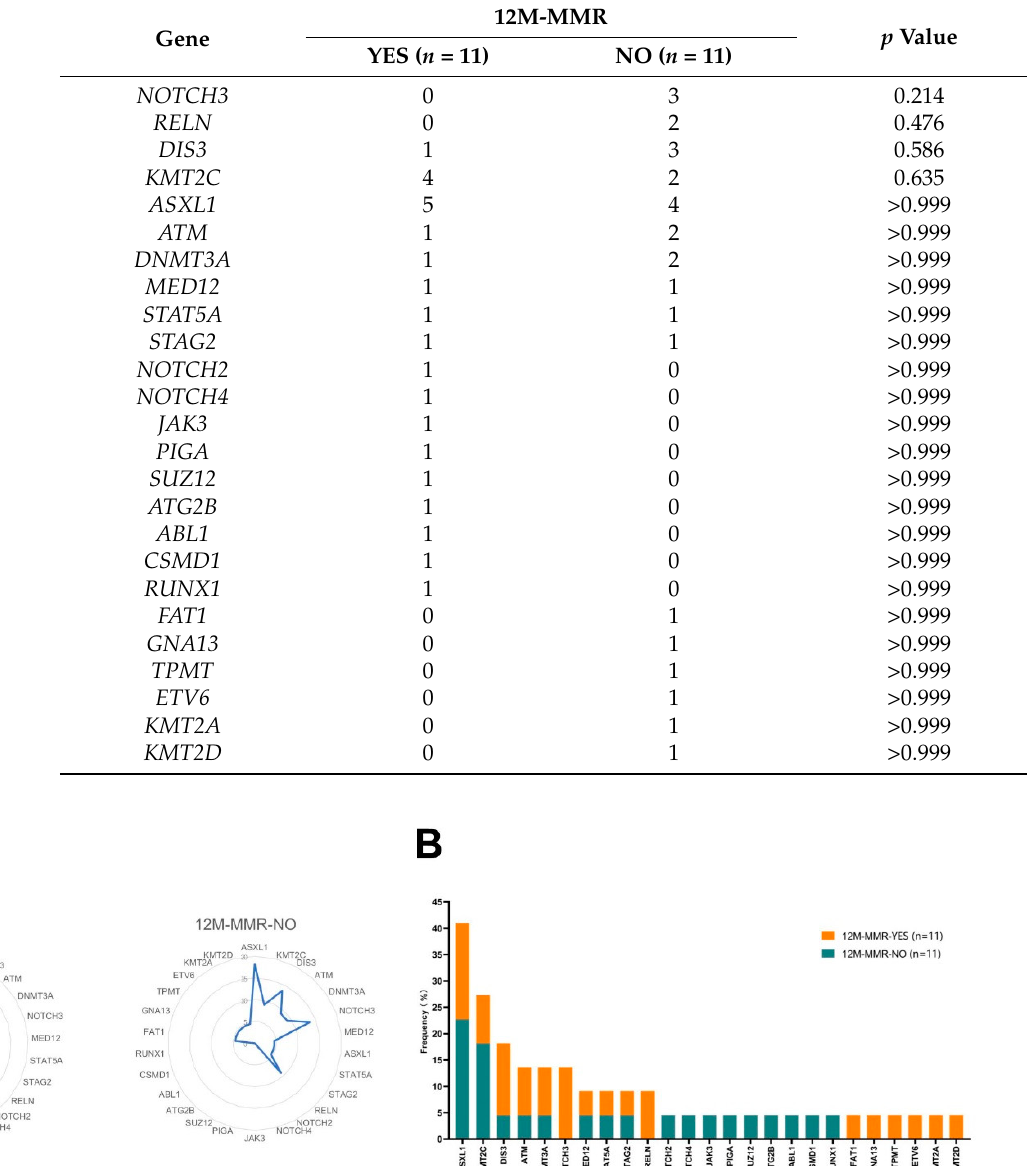
Table 2. Mutation analysis in the 12M-MMR group and non 12M-MMR group.